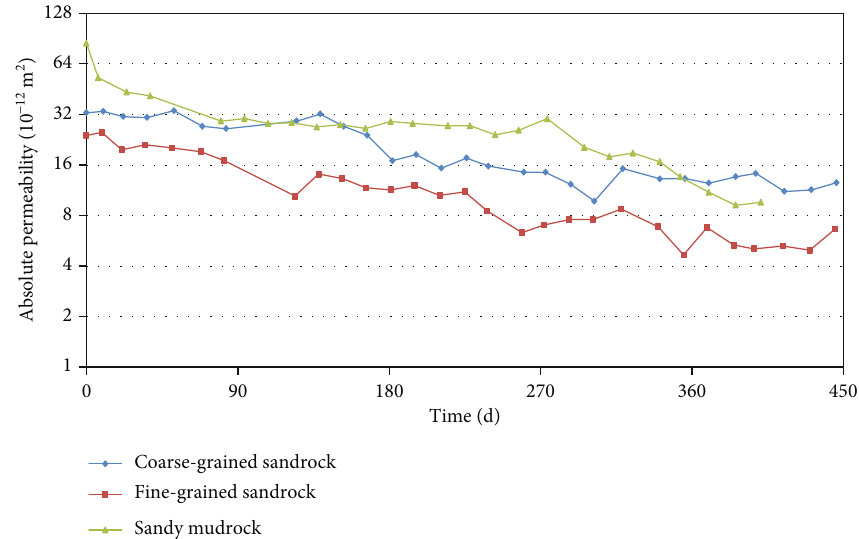
Figure 3: Absolute permeability of the three specimens over time.